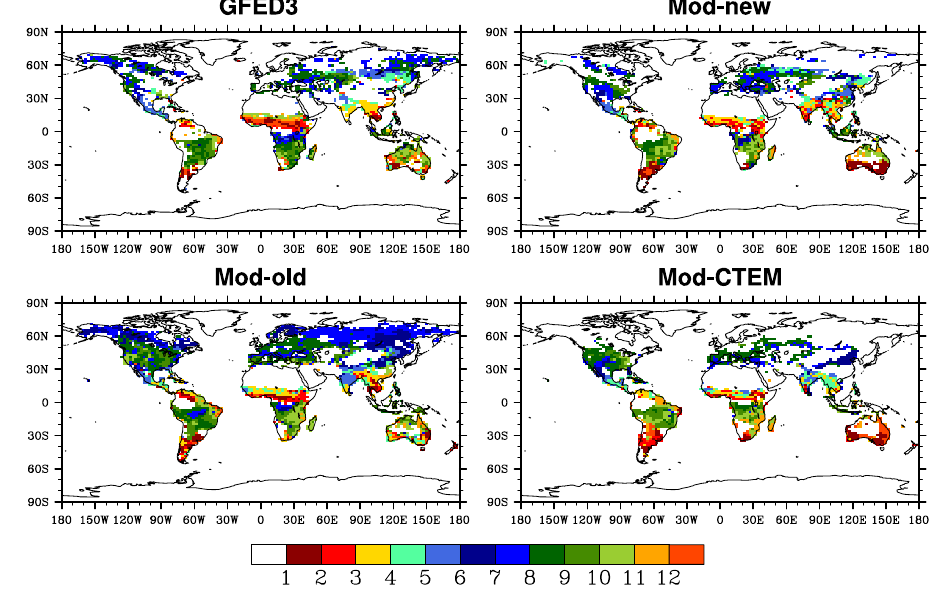
Fig. 11. Same as Fig. 9, but for month of maximum burned area for those areas where burned area fraction >